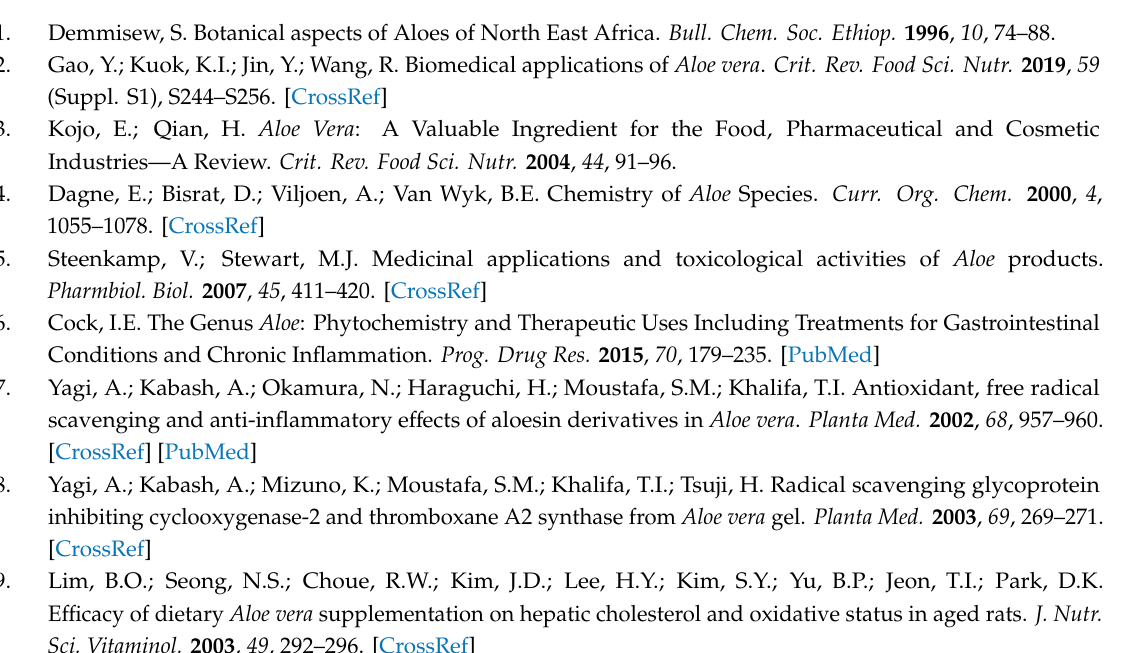
Figure S1: A photo of Aloe vacillans ., Figures S2–S24 NMR spectral data (1D and 2D0 of compounds 3 , 10 and 11 : while Figures S9, S16 and S23 are HRESIMS spectra of compounds 3 , 10 and 11 and Figure S24 is the HRESIMS for the known